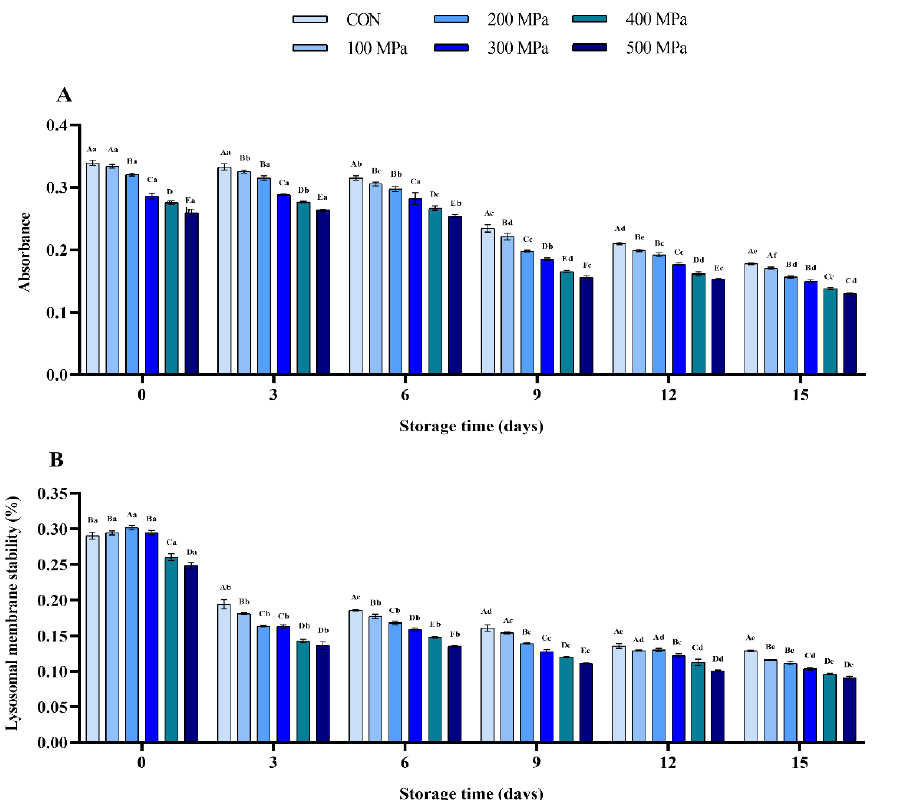
Figure 4. Effects of UHP treatment on the ( A ) mitochondrial suspension absorbance and ( B ) lysosomal membrane stability of shrimp during storage.